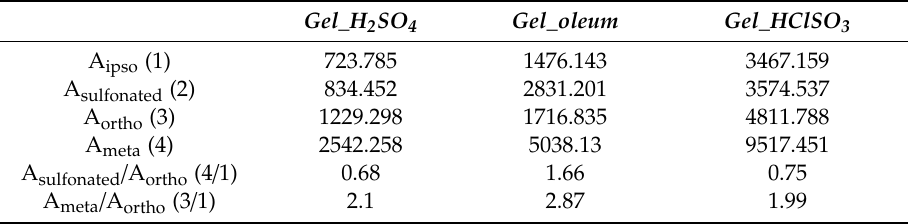
Table 5. Integrated intensities (absolute units) of the signals of aromatic carbon